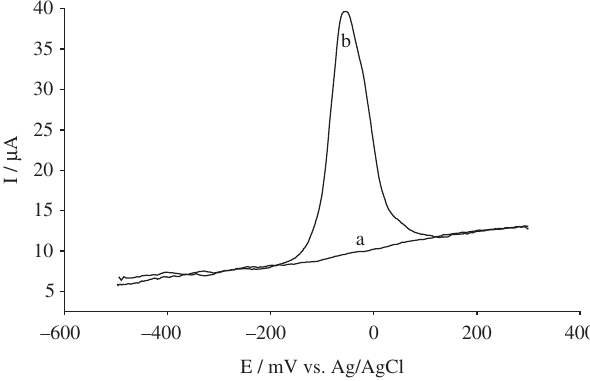
Figure 5. Cyclic voltammetric curves recorded in 5 mM Fe(CN) electrodes : a) bare Au; b) after deposition of film, c) after surfactant removal and d) Au/TFSF. Voltammograms obtained 50 mV/s scan